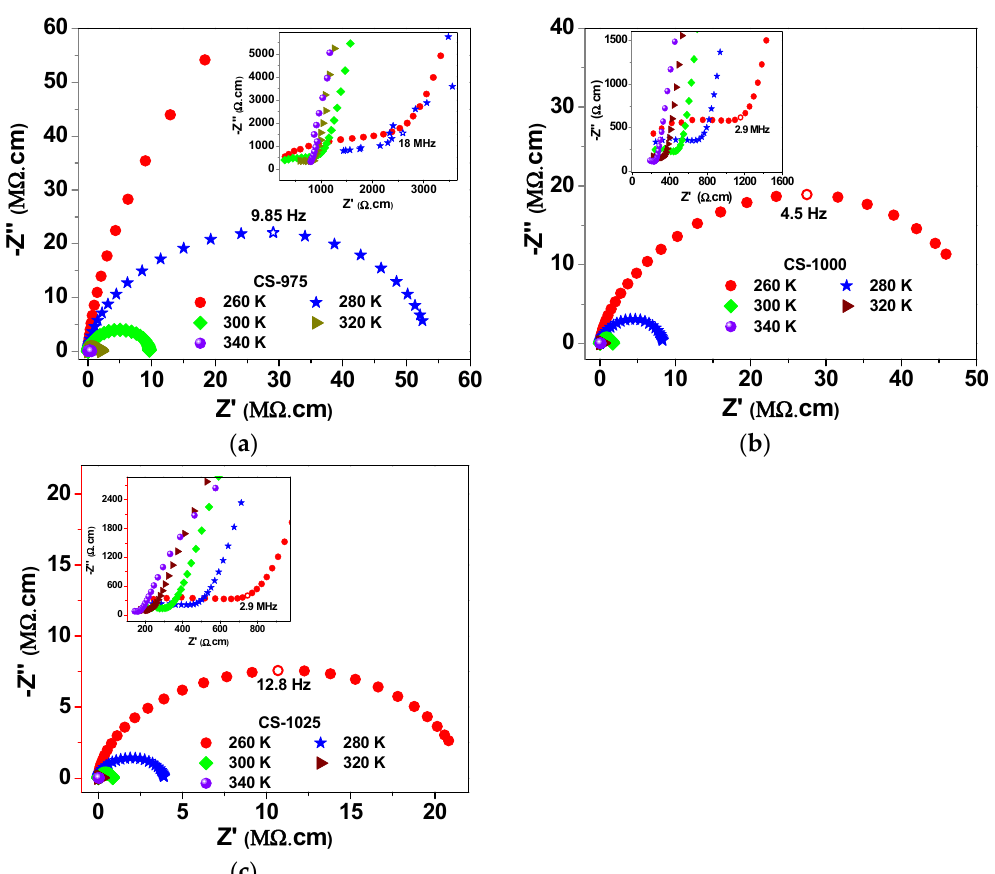
Figure 4. Complex impedance diagrams at selected temperatures for ( a ) CS-975, ( b ) CS-1000, and ( c ) CS-1025 LCTO ceramic. The insets show the high-frequency semicircles that correspond to grain response, whereas the large semicircles in the main graph represent the grain boundary contribution.